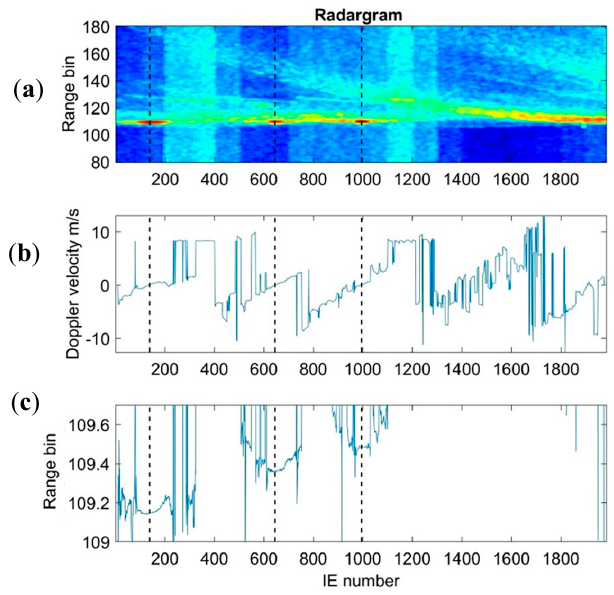
Figure 14. River slope estimate in: ( a ) radargram; ( b ) Doppler velocity; ( c ) range bins.